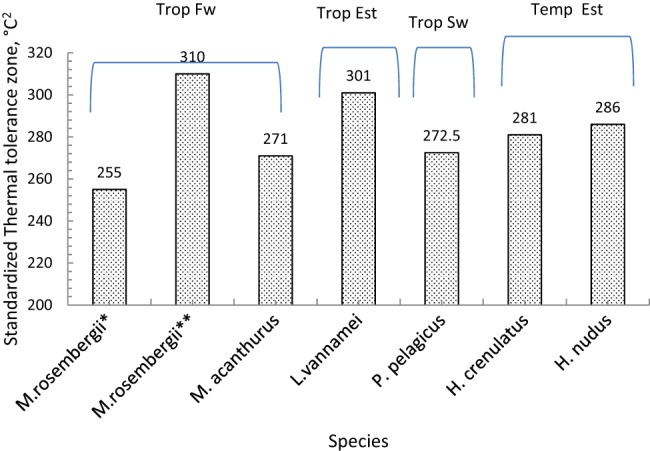
Thermal tolerance zone (area) standardized to 10°C intervals of acclimation temperatures for prawns, shrimps and crabs with different geographic distributions. An analysis of standardized thermal tolerance areas (TTAs) of a range of crustaceans revealed considerable differences in TTA between tropical and temperate marine and estuarine species. Trop Fw, tropical and fresh water habitat; Trop Sw, tropical and sea water habitat; Trop Est, tropical and estuarine distribution; Temp Est, temperate and estuarine distribution. Species analysed: Macrobrachium rosembergii* (Manush et al., 2004); M rosembergii** (Díaz Herrera et al., 1998); M. acanthurus (Díaz et al., 2002); Litopenaeus vannamei (González et al., 2010); Portunus pelagicus (Qari and Aljarari, 2014); Hemigrapsus crenulatus (this study); H. nudus (McGaw, 2003).